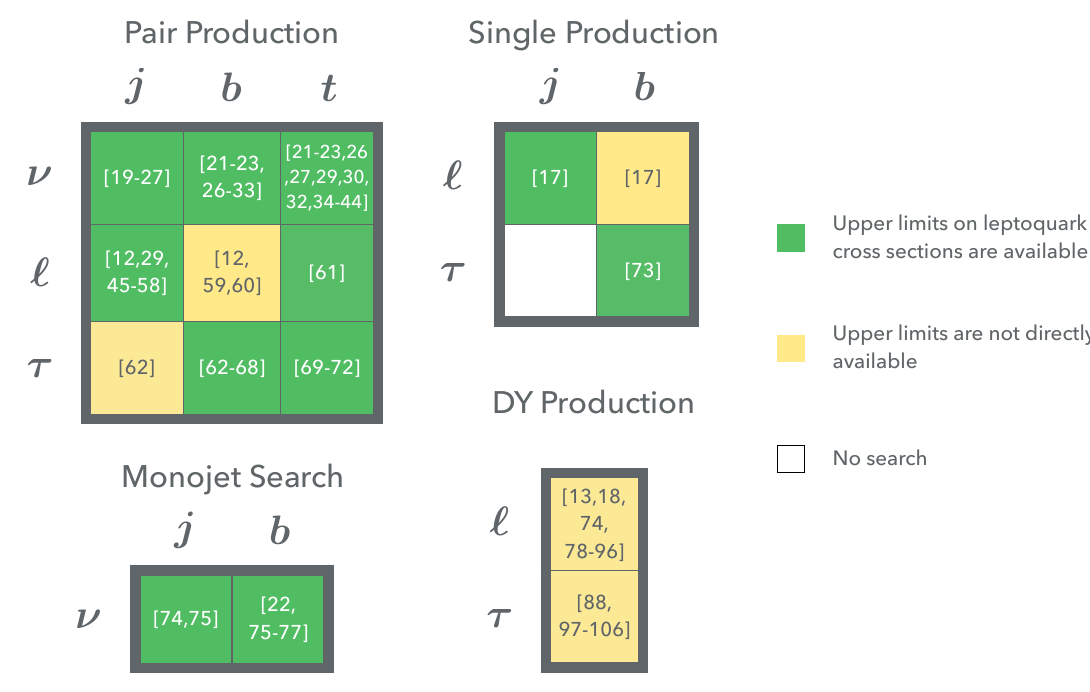
Figure 7. Summary of the current status of searches for pair (upper-left), single (upper-right), monojet (lower-left) and DY production (lower-right) of leptoquarks at the LHC after Runs 1 and 2. Each entry corresponds to a speci(cid:12)c (cid:12)nal state in an experimental search. We include searches for leptoquarks, dark matter, and supersymmetry, which have identical (cid:12)nal states and decay topologies. For such searches one can directly obtain limits on the LQ cross section from the experimental papers, we color such matrix elements in green. Final states for which we obtained limits on the cross section indirectly by reinterpreting a related search are colored in yellow. Final states for which no search has been performed so far are left white. The numbers give the references relevant to the various (cid:12)nal states. Pair production matrix: ( (cid:23)j ) [19{27], ( (cid:23)b ) [21{23,